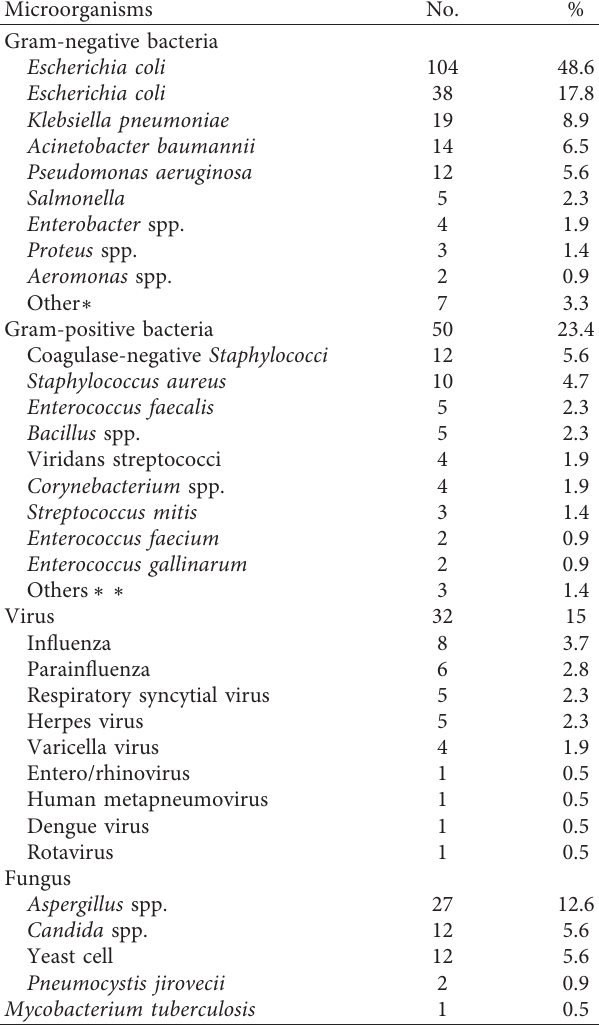
Table 4: Causative microorganisms from 214 clinical specimens. Microorganisms